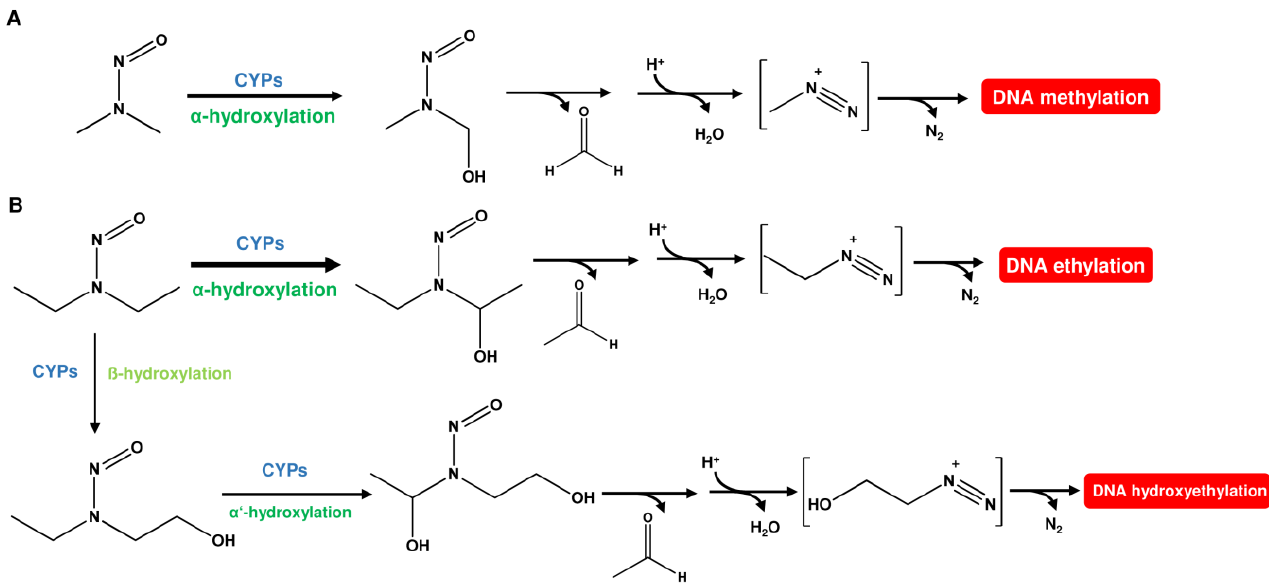
Figure 3. Metabolic activation pathways for NDMA and NDEA. A N -nitrosodimethylamine (NDMA) undergoes hydroxylation by CPYs to form N -nitroso(hydroxymethyl)methylamine. This phase I metabolite rearranges under the release of formaldehyde and water to an unstable methyl- diazonium ion, which then methylates the DNA. B N -nitrosodiethylamine (NDEA) is primarily hy- droxylated at the α -carbon by CYPs. The hydroxylated metabolite then rearranges under the release of acetaldehyde and water to an unstable ethyldiazonium ion, which causes DNA ethylation. NDEA can also undergo ß-hydroxylation as a minor pathway, resulting in the formation of an unstable hydroxyethyldiazonium ion that can hydroxyethylate the DNA.